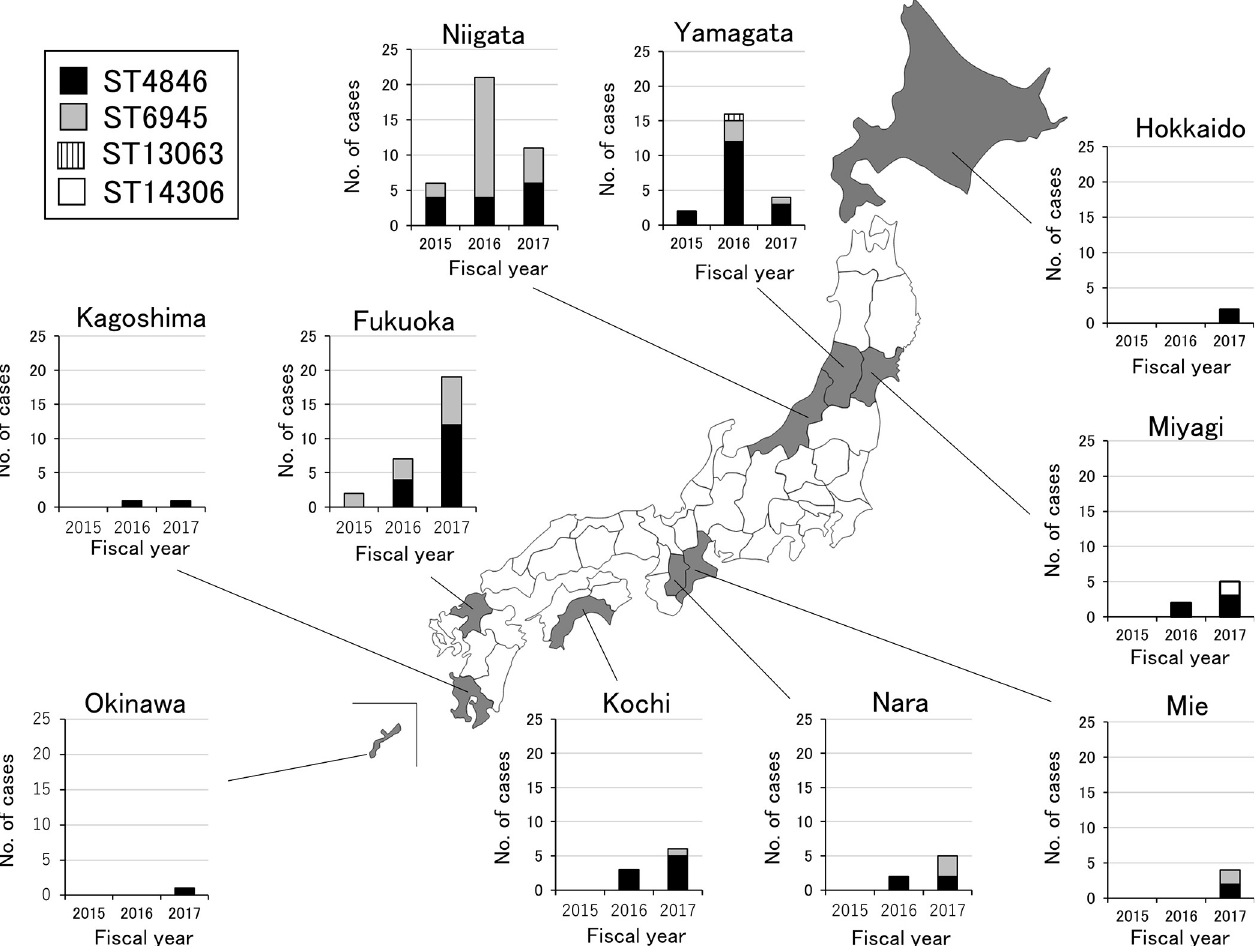
Fig 2. The number of cases of invasive pneumococcal disease in Japan caused by 12F serotype with sequence types 4846 (closed bar), 6945 (grey bar), 13063 (stripe bar) and a new sequence type (open bar) in 10 prefectures during April 2015 to March 2016, April 2016 to March 2017, and April 2017 and March